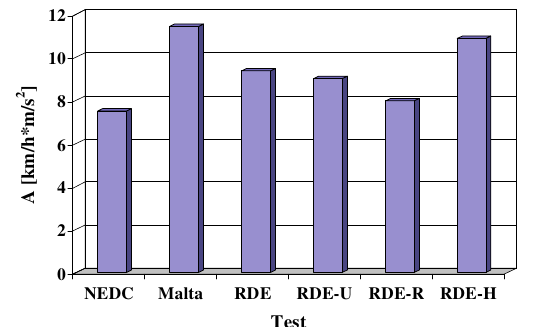
Fig. 12. Mean particle number road emissions – b PN in each of the test cycles